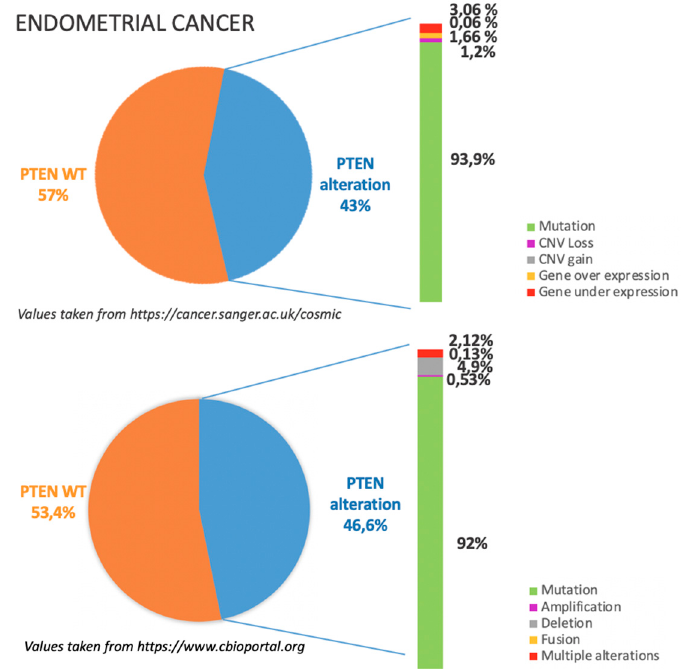
Figure 3. The incidence and type of PTEN alterations according to COSMIC and TGCA datasets in endometrial cancer.